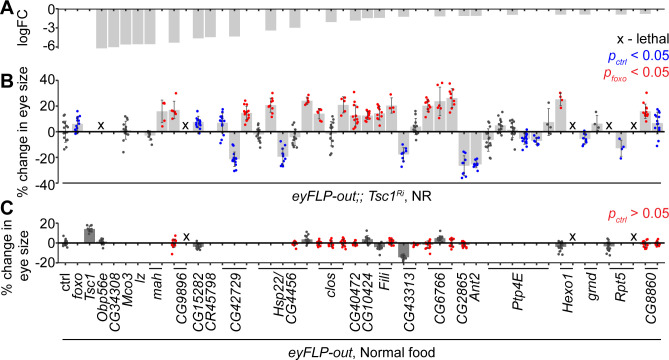
In vivo RNAi assay to validate downregulated genes in Tsc1 mutant cells upon foxo knockdown.(A) log fold change (FC) of downregulated genes in Tsc1 mutant cells with foxo knockdown versus Tsc1 mutant cells under NR. (B) Percentage change in adult eye size upon knockdown of candidate genes in Tsc1 knockdown background under NR. n > 3. Blue or red points represent a significant (p<0.05) change as compared to ctrl or foxo knockdown, respectively. The RNAi lines are ordered as in the Materials and methods. (C) Percentage change in adult eye size upon knockdown of candidate genes in wild-type background on normal food. n > 9. Red points represent a non-significant (p>0.05) change as compared to ctrl. Data are represented as mean ± SD.